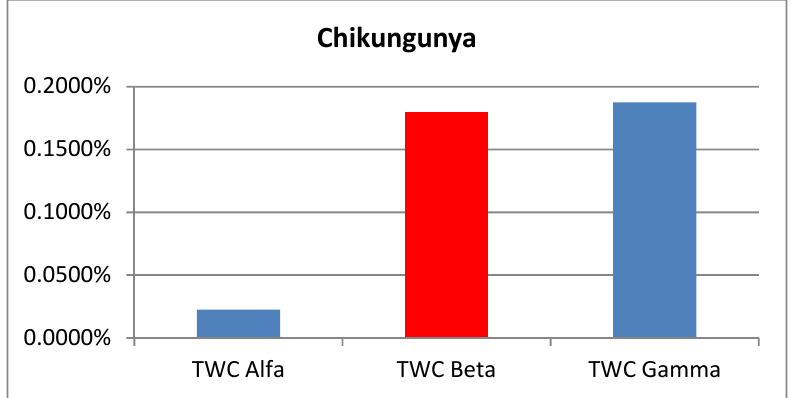
Figure 2. Areas of p > 0.95 according the TWC α , β and γ , in Chikungunya epidemics.